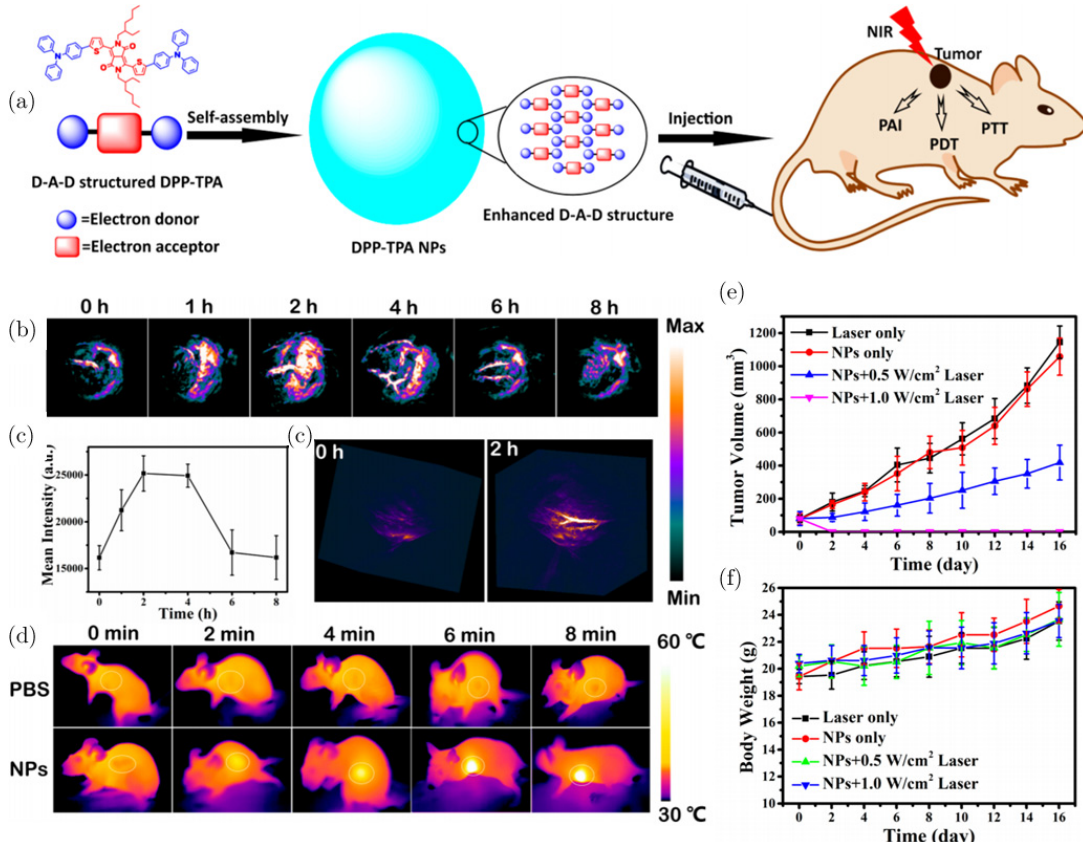
Fig. 7. (a) – (f) DPP-TPA CPNs for PAI-Guided PDT/PTT and the therapeutic e®ect of tumor sites after injecting DPP-TPA